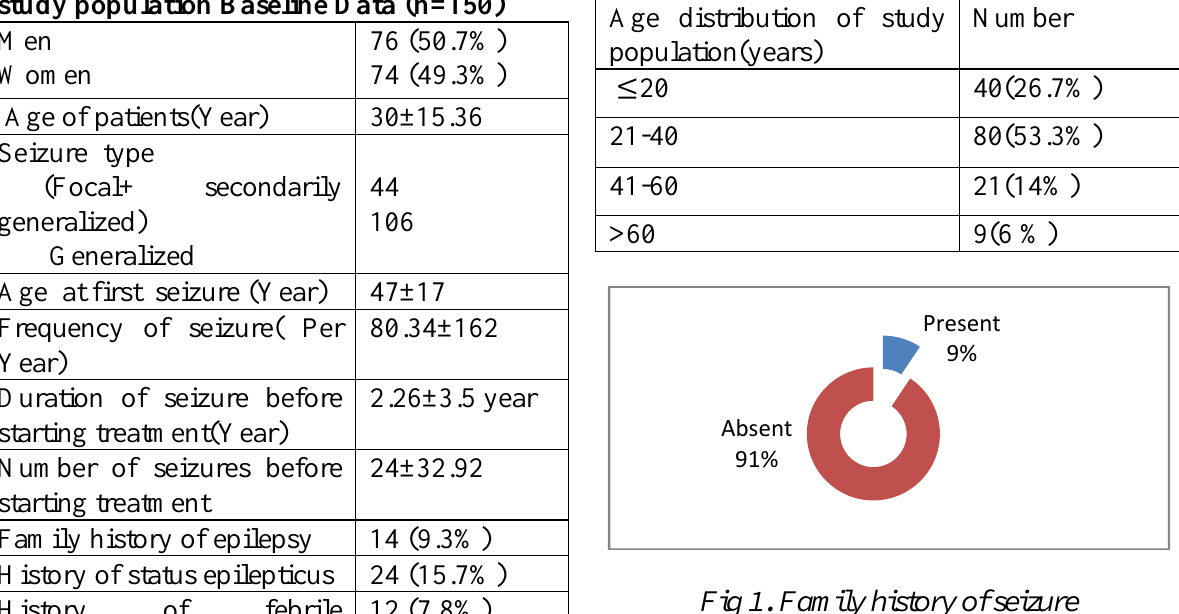
Fig 1. Family history of